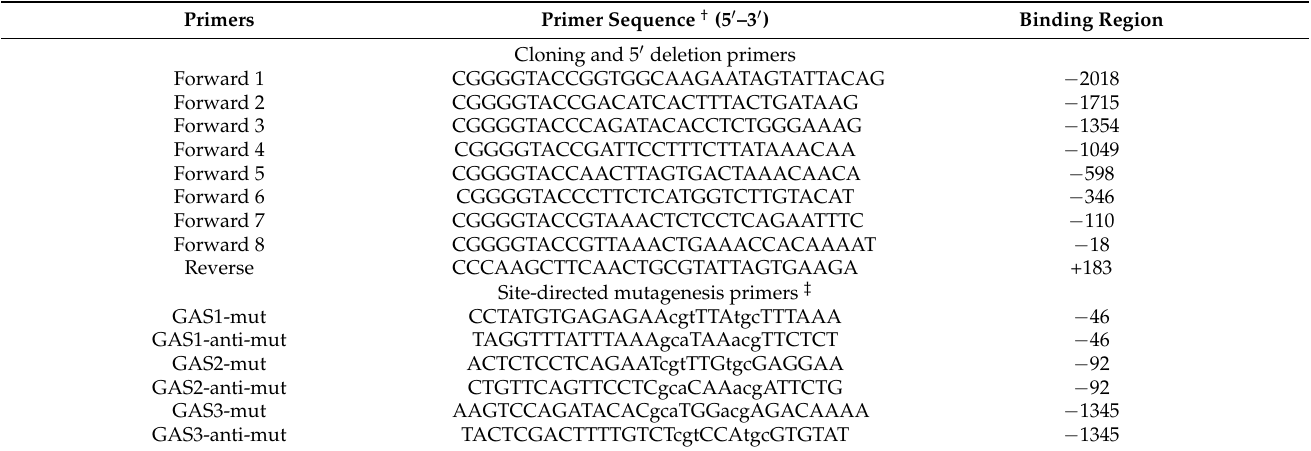
Table 1. Primers used for cloning, deletion and site-directed mutagenesis of the goat CSN1S1 gene. Primers Primer Sequence † (5 (cid:48) –3 (cid:48)